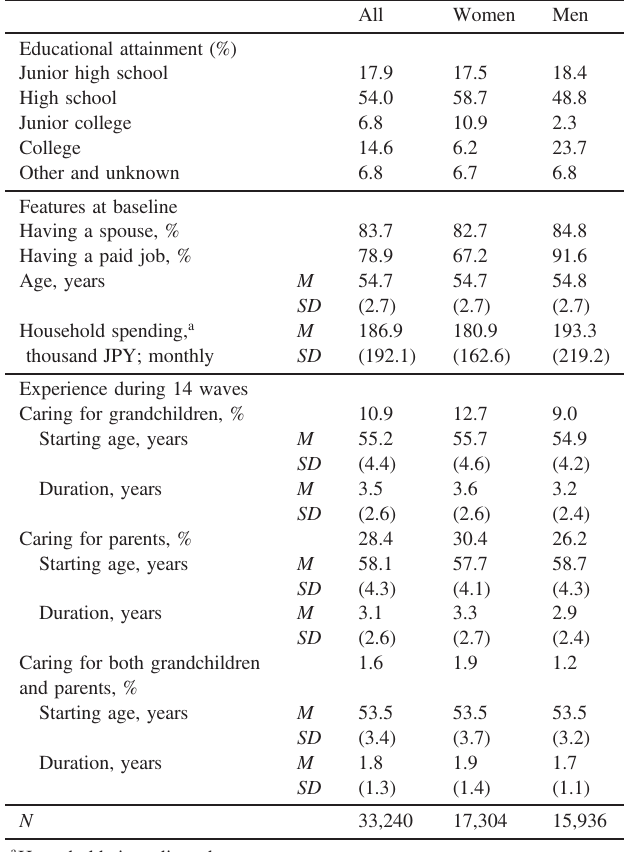
Table 1. Key features of the study sample